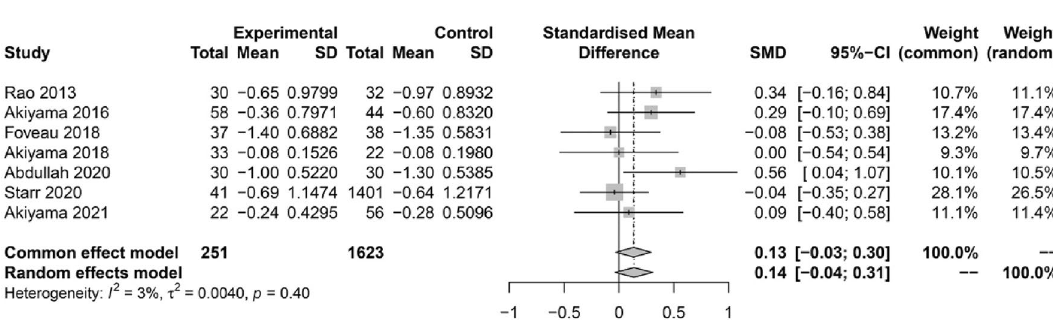
Figure 2. A forest plot showing the rate of epiretinal membrane formation following primary RD repair with and without prophylactic ILM peeling.